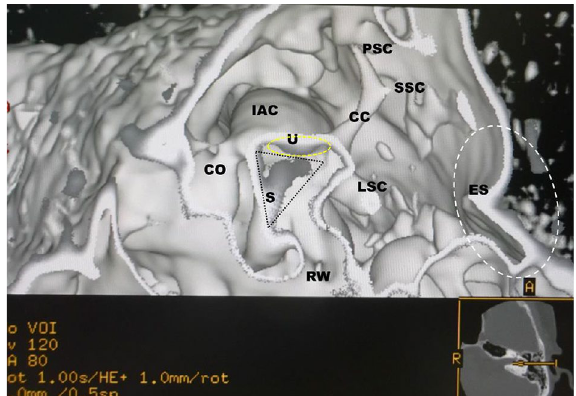
Figure 7. In the parasagittal view from the same subject as in Fig. 6, the saccular macula (black dotted triangle) is enlarged to the extent that it is in contact with the utricular macula (yellow dotted oval). The endolymphatic sac (white dotted oval) is grayish. The same gray-colored tissue is found in the cerebellopontine angle cistern. U utricular macula (yellow dotted oval), S saccular macula (back dotted triangle), LSC lateral semicircular canal, PSC posterior semicircular canal, SSC superior semicircular canal, ES endolymphatic sac (white dotted oval), CC common crus, RW round window, IAC internal auditory